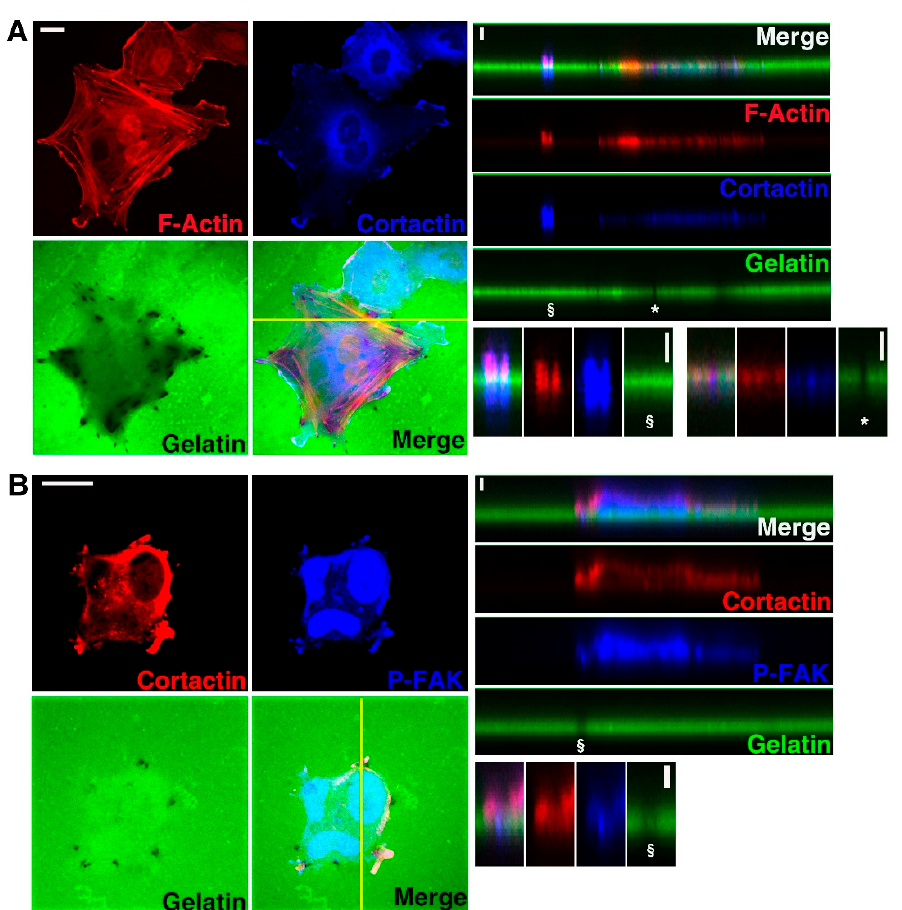
Figure 1. U251 cells form invadopodia. Cells were cultured on coverslips coated with FG-gelatin (1.5 × 10 4 cells/mL) and observed by confocal microscopy in the xy dimension. After 5 h, the localization of ( A ) F-actin (Red) and cortactin (Blue) or ( B ) cortactin (Red) and P-FAK (Blue) was determined by indirect immunofluorescence or using TRITC-phalloidin. Invadopodia formation (*) and focal adhesions (§) were observed. Each left panel is xy images, right top panel is xz images and right bottom panel is a xz enlargement of the regions of interest (N = 10). The yellow line in the xy images is the axis shown in the xz dimension (Scale bar: 20 µm on xy dimension and 2 µm on xz dimension).